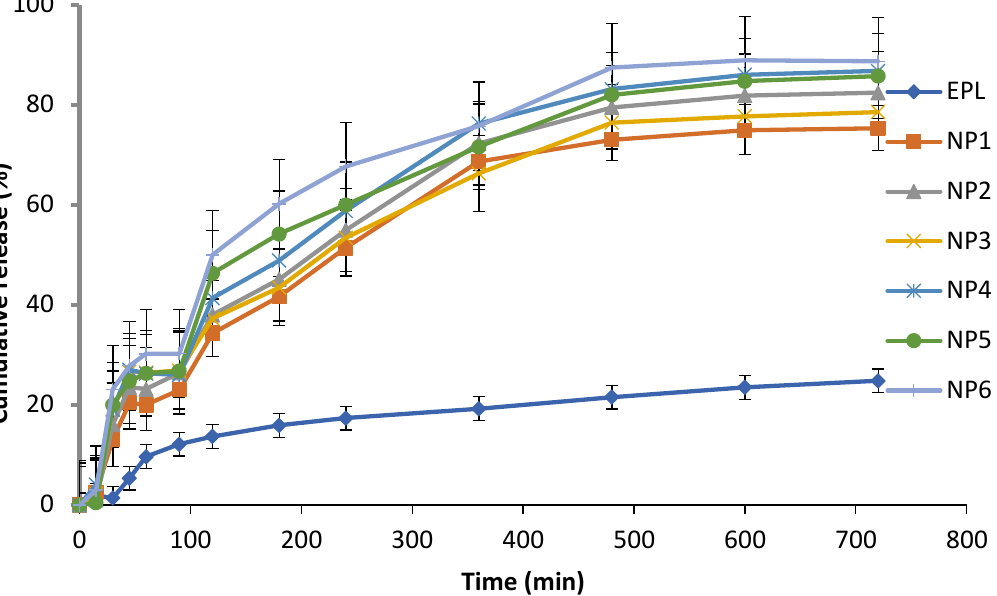
Figure 3. Drug release of EPL, NP1, NP2, NP3, NP4, NP5 and NP6 in a buffer of pH 6.8.